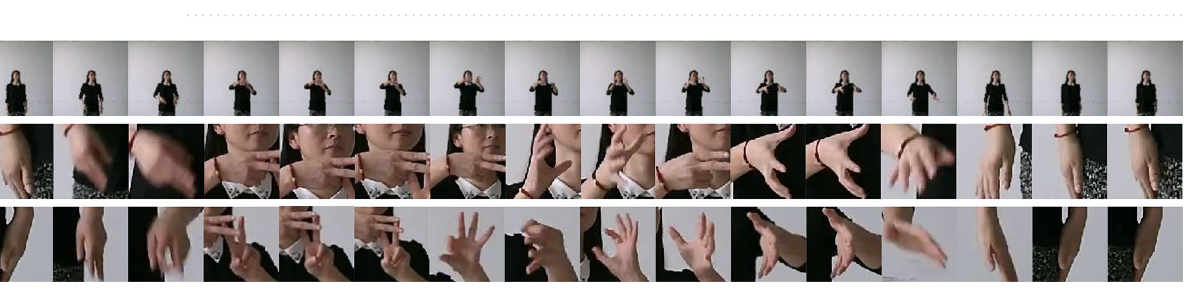
Figure 12. Pseudocode of improved residual network.